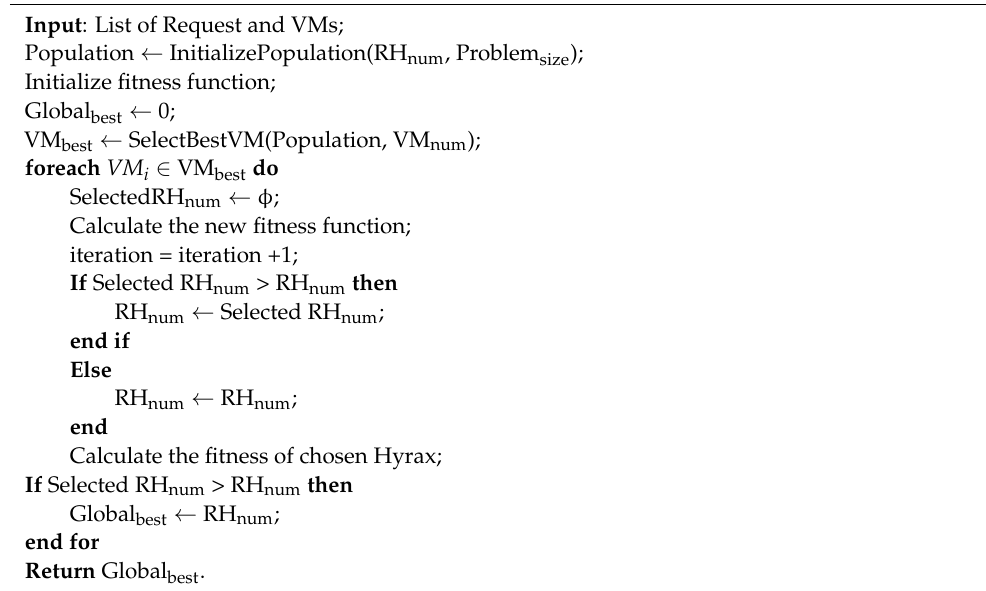
Algorithm 2. Rock Hyrax Load Balancing